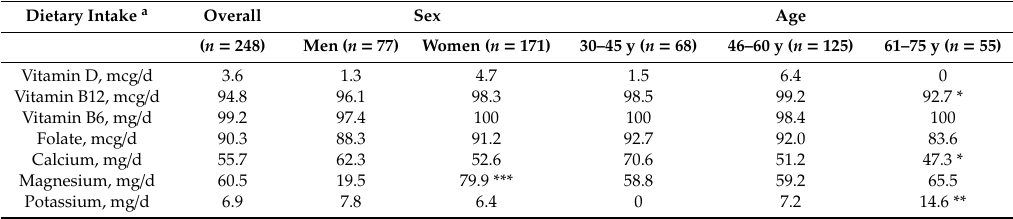
Table 2. Percent of adults living in Puerto Rico meeting the age- and sex-specific dietary recommended intake of